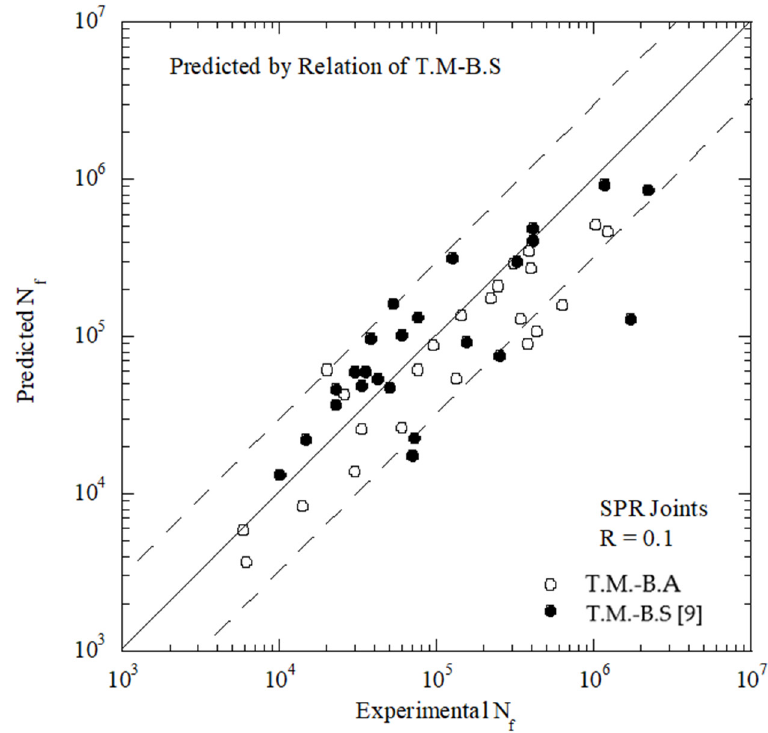
Figure 18. Fatigue lifetime predictions of the T.M-B.A and T.M-B.S SPR joints under three loading conditions adopting the relationship of T.M-B.S [9].